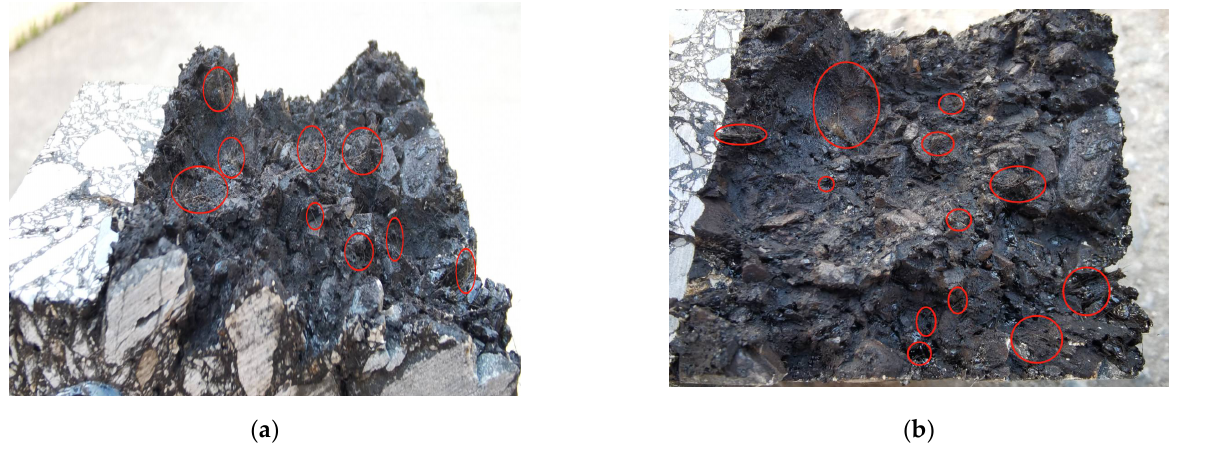
Figure 9. The basalt fibers on the fracture section: ( a ) Specimen T1, ( b ) Specimen T2. From the perspective of fracture mechanics, the fracture energy is used to represent test, the area enclosed by the load-deflection curve and the coordinate axis is the fracture energy [31]. The failure load and fracture energy of S1–S6 of OAC and T1–T6 of BFAC are shown in Figure